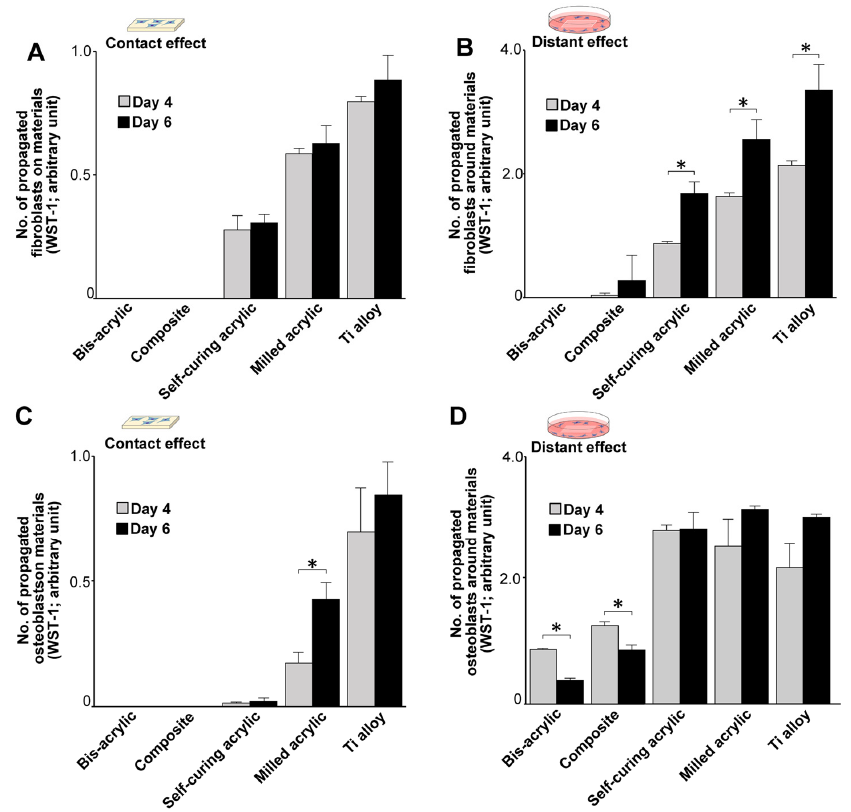
Figure 4. Cell propagation after initial settlement (days 4 and 6). ( A ) The number of propagated cells on test materials. ( B ) The number of propagated cells around test materials. ( C ) The number of propagated osteoblasts on test materials. ( D ) The number of propagated osteoblasts around test materials. Data shown are means ± SD (n = 3). Significant differences are shown (Student’s t -test, * p < 0.05).